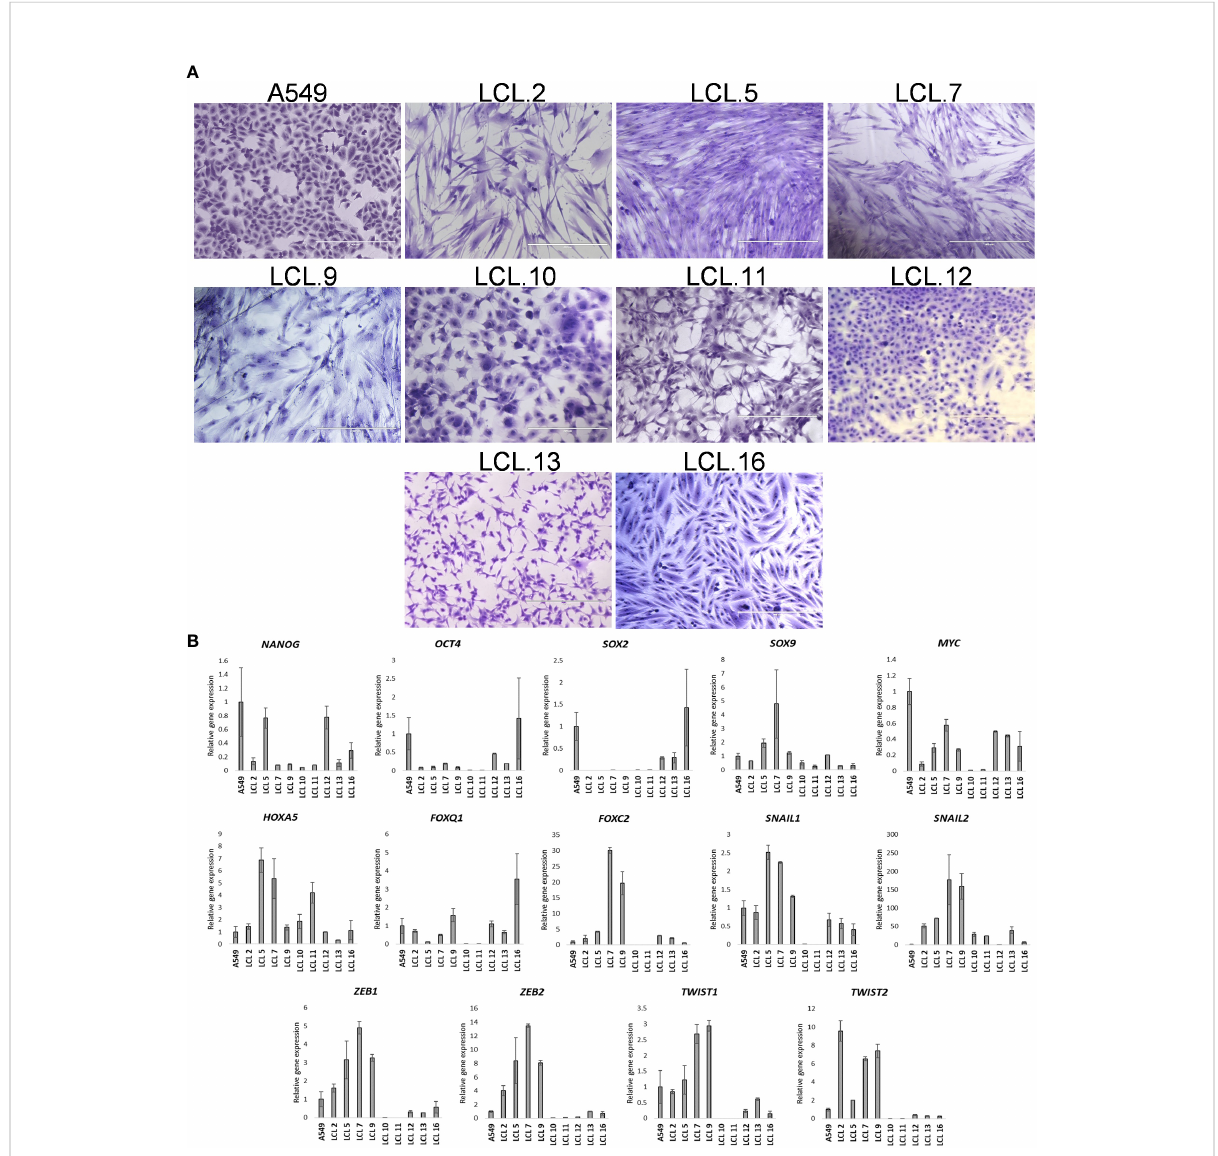
FIGURE 1 Human NSCLC tumor-derived cell line characterization. (A) Morphology of cells from A549 and primary cell lines grown in vitro for more than 10 passages. Scale bars = 400 µm. Cells have been stained with crystal violet dye. (B) The relative expression of stem cell- and EMT-related transcription factors as determined by RT-qPCR (in respect to GAPDH ). Data are presented as the mean ± SD (N =